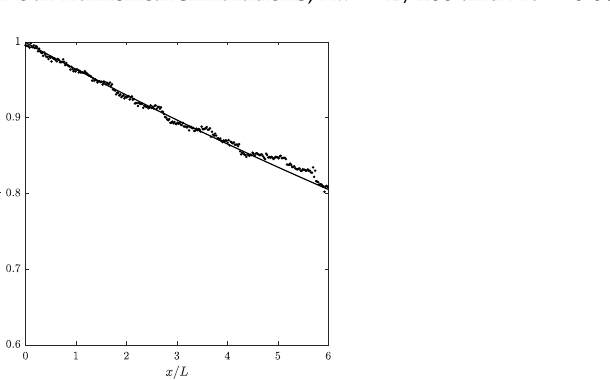
Figure 6. Waves over a viscous fluid bottom without obstacles: amplitude ratio, a / a 0 , as a function of dimensionless propagation distance, x / L . Dot: present numerical results. Line: existing analytical predictions [70]. In this example, T = 1.79 s, d = 0.8 m, ν m = 0.003 m 2 /s, ρ m = 1111 kg/m 3 , and d m = 0.0413